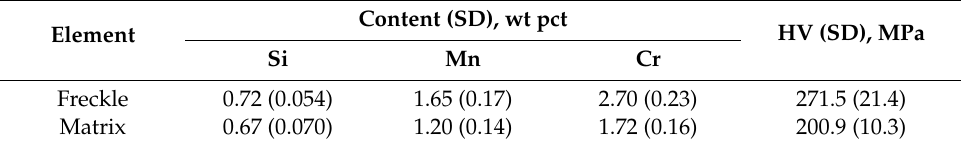
Table 2. Compositions and hardness of the freckle and the surrounding